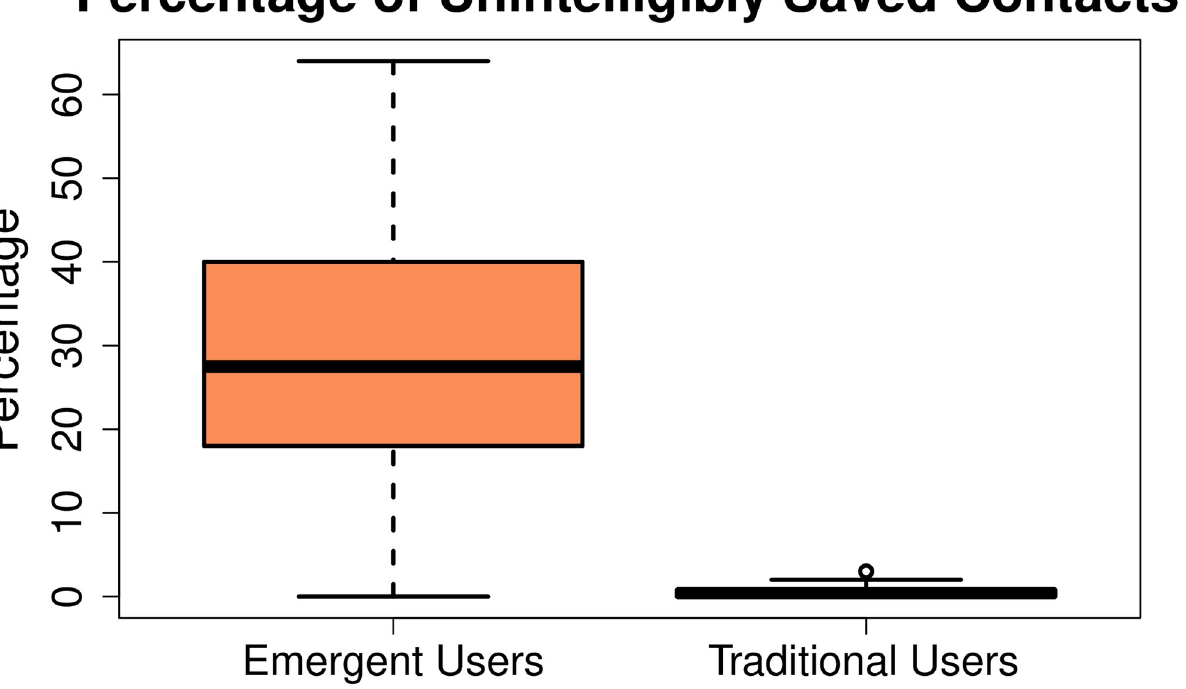
Fig 6. The contact-books of emergent users had a large number of contacts which were not saved using any meaningful names. The mean percentage of unintelligible contact names of emergent users came out to be 35.5% (s.d 23.6%) whereas, traditional users only had a negligible number of unintelligible contact names with the mean percentage of 0.48% (s.d.65%).